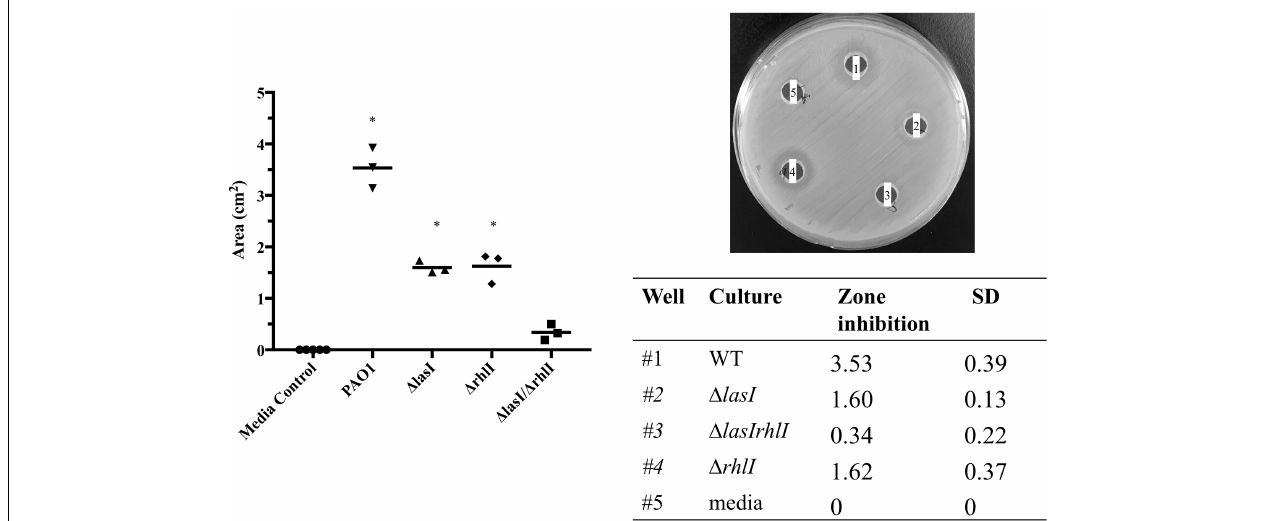
FIGURE 6 | Effect of P. aeruginosa mutant supernatant on S. aureus growth. Supernatant of the PAO1 WT, (cid:49) lasI , (cid:49) lasIrhl , and (cid:49) rhll strains of P. aeruginosa were added to an agar plate containing a lawn of S. aureus . The lawns were allowed to grow for 24 h and zones of inhibition were measured using ImageJ. ∗ p < 0 . 001 compared to media control.